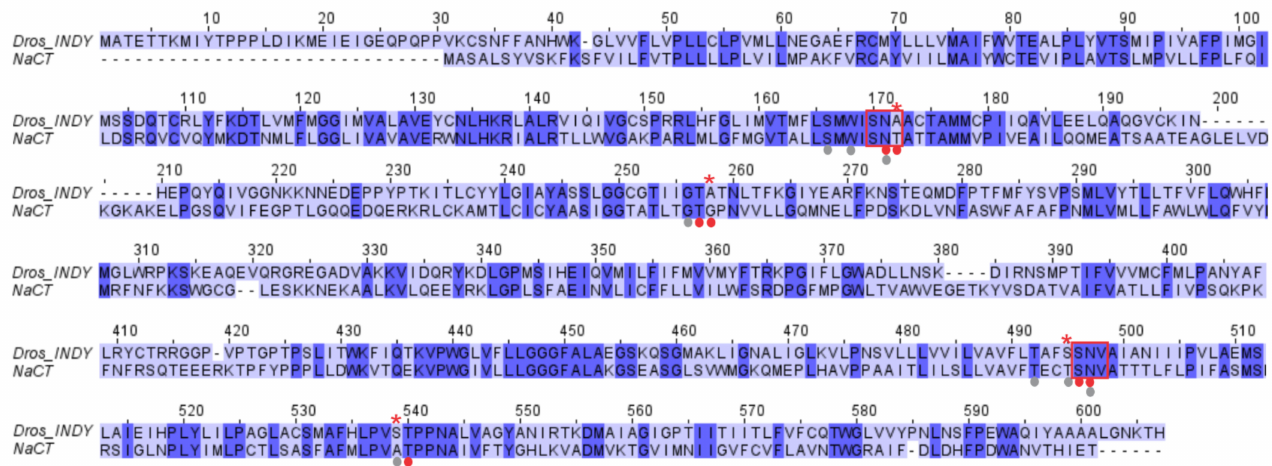
Figure 3. Sequence alignment of Drosophila INDY and human INDY (NaCT). Dots below the sequence indicate binding residues for citrate (red) and Na + (gray) based on the cryo-EM structure of human INDY [28]. The degree of residue conservation increases from light blue to dark blue. Red asterisks above the sequence show amino acids in Drosophila INDY that are different from the amino acids constituting the Na + and citrate binding sites in human INDY. The SNT/V motifs are shown in red boxes. The accession numbers for the protein sequences are Q9VVT2 for Drosophila INDY and Q86YT5 for human